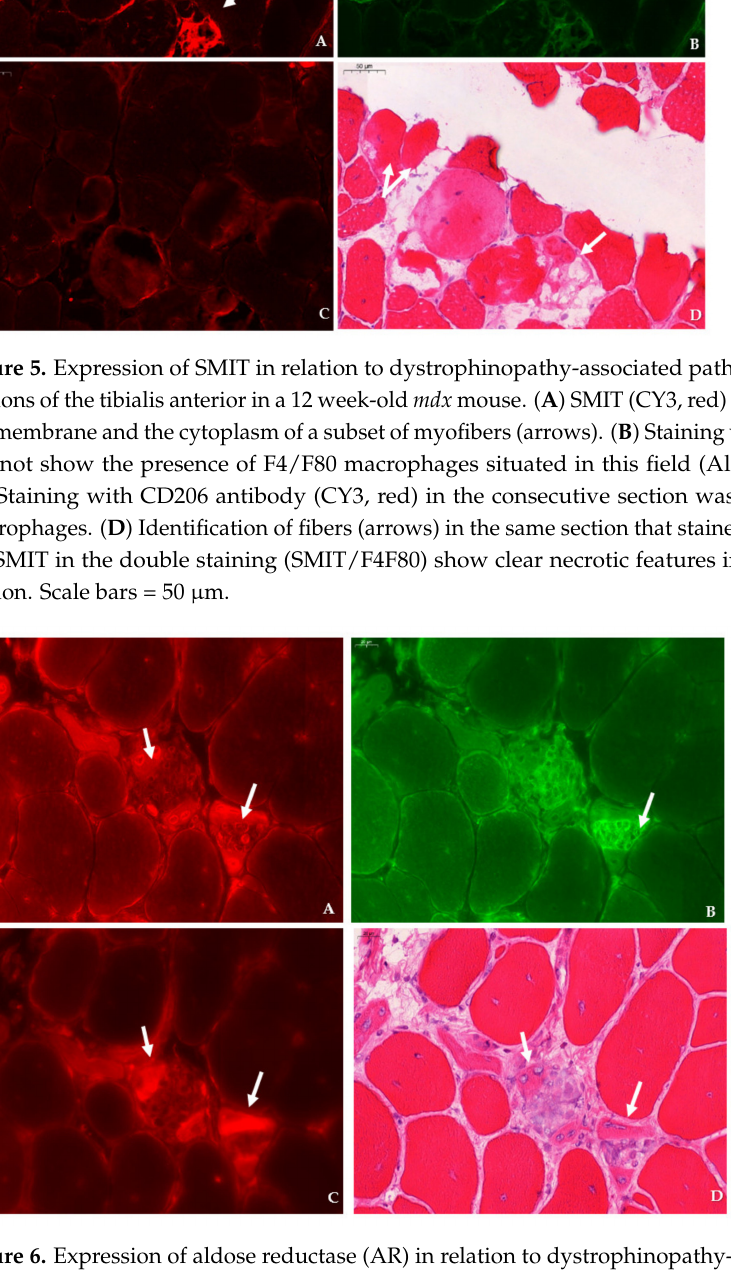
Figure 6. Expression of aldose reductase (AR) in relation to dystrophinopathy-associated pathology in consecutive sections of the tibialis anterior in a 12 week-old mdx mouse. ( A ) AR (CY3, red) is highly expressed in small regenerating myofibers (arrows). ( B ) F4/F80-positive macrophages (AlexaFluor 488, green) indicated by arrows, are located in the vicinity of AR positive myofibers. ( C ) Staining of a consecutive section with CD206 antibody (CY3, red, arrows) shows a clear colocalization with AR-positive fibers observed in panel A. ( D ) Identification of small regenerative fibers with central nuclei (arrows) in H&E section that stained previously positive for the presence of AR in the double stain (AR/F4F80). Scale bars = 20 µ